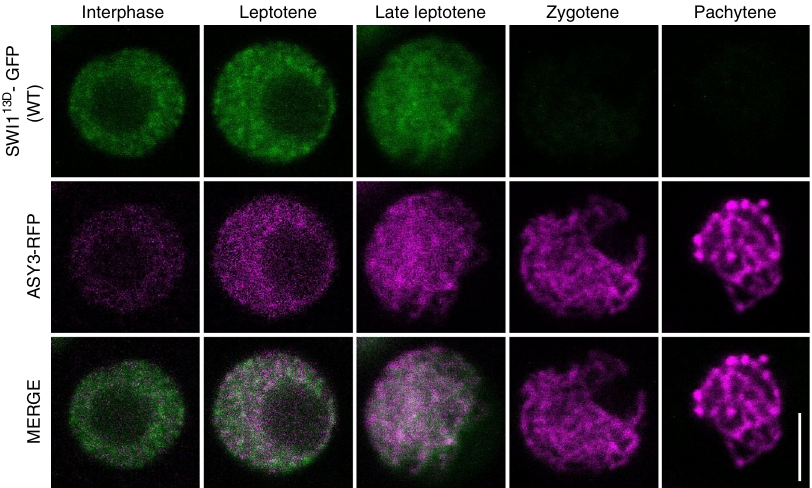
Fig. 7 Localization of the phosphomimic version of SWI1. The localization of the phosphomimic version SWI1 13D -GFP is indistinguishable from the wild-type SWI1-GFP version (compare with Fig. 2a). ASY3-RFP is used for staging. Bar: 5